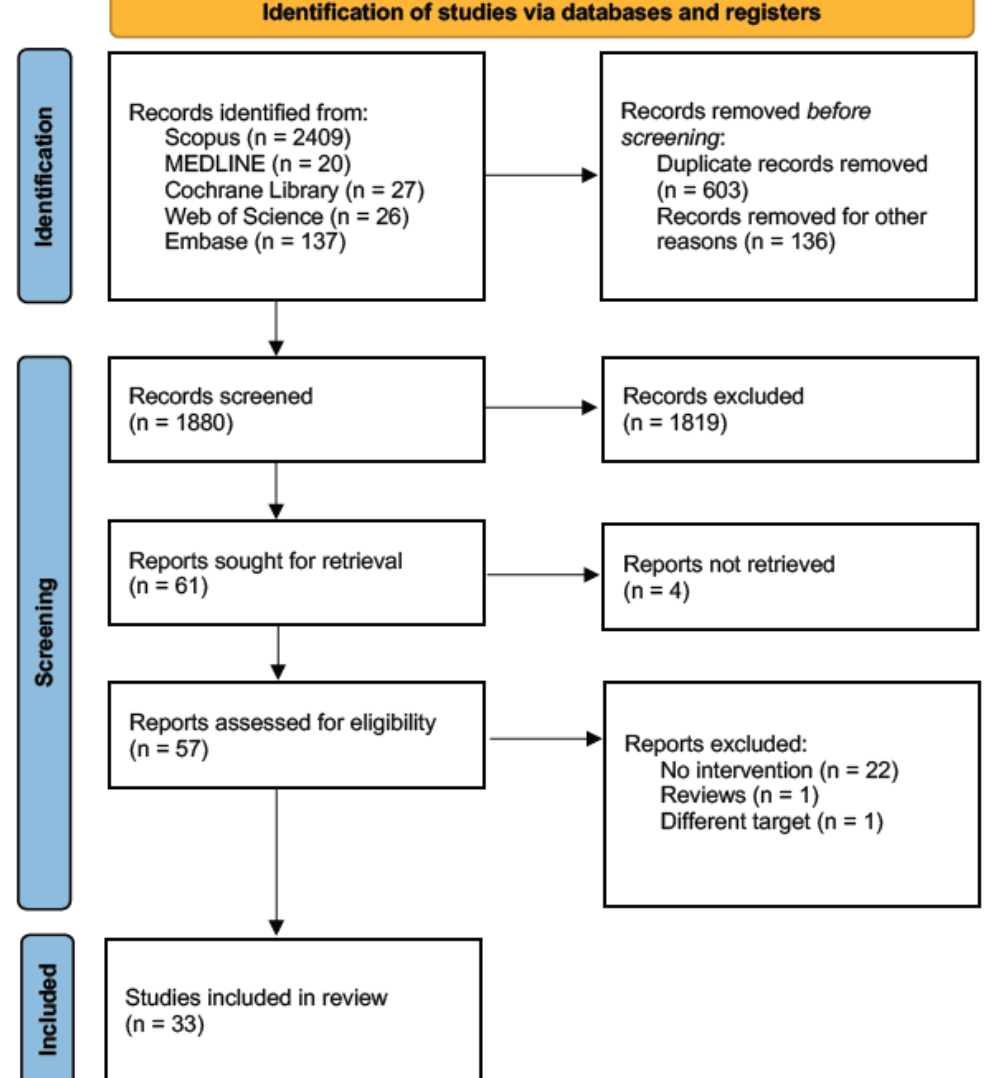
Figure 1. PRISMA flow diagram of different screening rounds.